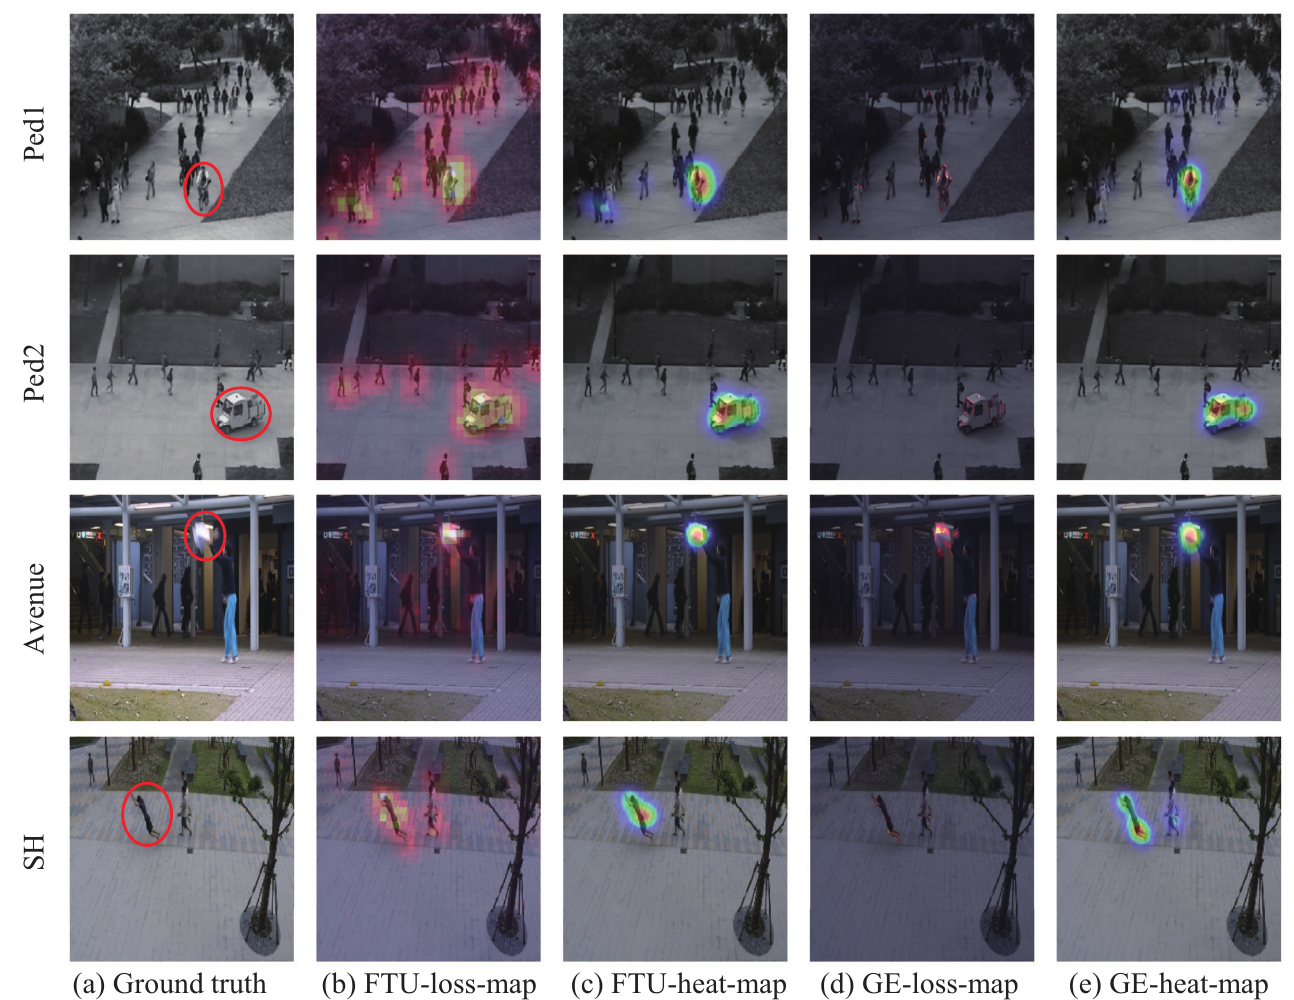
Figure 5. Anomaly-detection visualization. ( a ) Anomalous frames in different datasets. The contents in red circles are anomalous events. ( b ) FTS loss’s intensity map. ( c ) FTS loss’s heatmap. ( d ) GE loss’s intensity map. ( e ) GE loss’s heatmap.